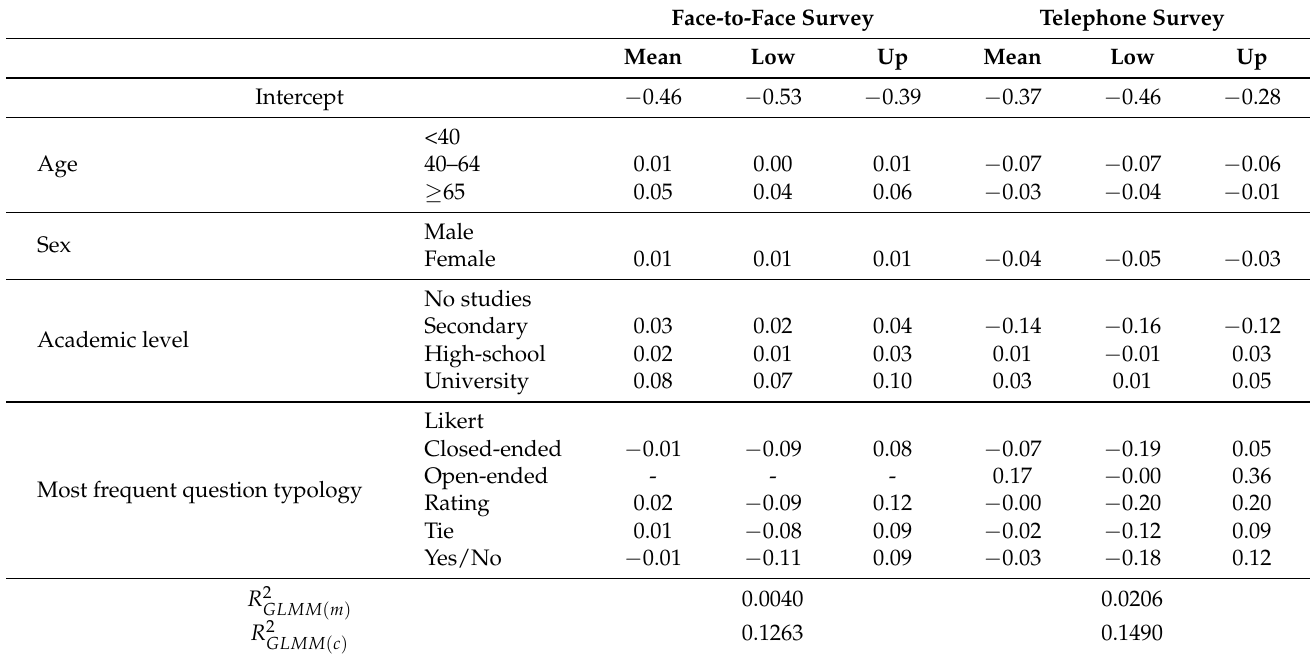
Table 4. Fixed-effect estimates corresponding to the modeling of the coefficient of unalikeability, following Equation (4), in terms of the mean of the posterior distribution of each parameter involved. The lower (Low) and upper (Up) bounds of the 95% credibility interval associated with each estimate are also